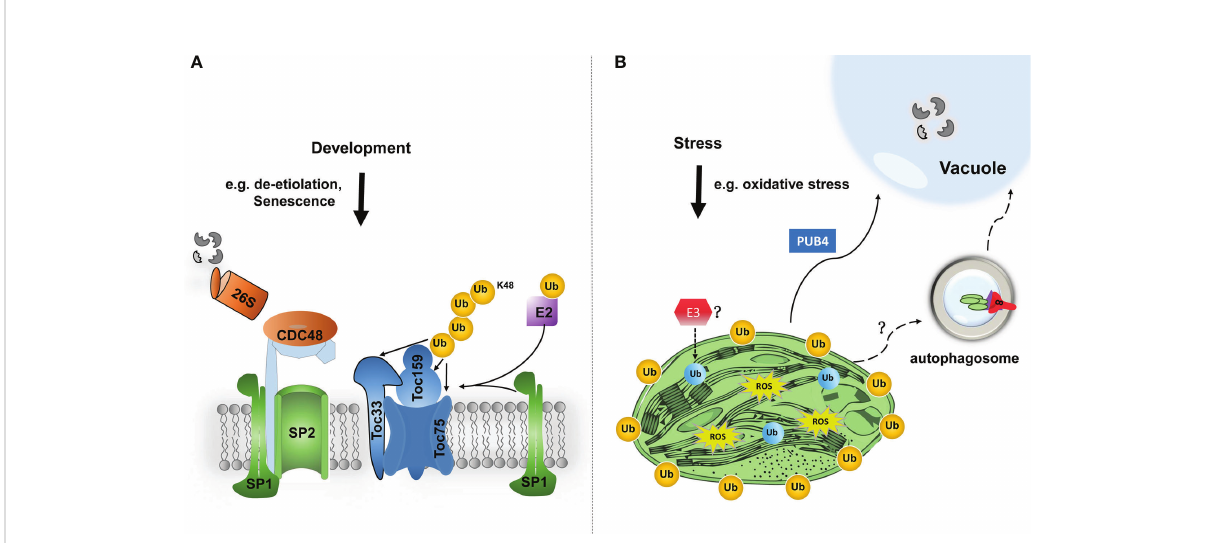
FIGURE 2 Modes of the functions of chloroplast protein ubiquitination in chloroplast proteostasis and functions. (A) In response to developmental signals, such as de-etiolation or fruit ripening, TOC components are ubiquitinated (Ub, in orange colour) by chloroplast-resident E3 ligase SP1 and an unknown cytosolic E2. Ubiquitinated TOC proteins are then retrotranslocated to the cytosol by SP2 channel and CDC48 chaperone, and fi nally degraded by the 26S proteasome. Such TOC turnover facilitates the reorganization of import machinery, and thereby changes the plastid proteome to cope with different developmental stages. (B) Under certain stress conditions, such as oxidative stress, photosynthesis tends to produce excessive reactive oxygen species (ROS), which will cause severe chloroplast damage. In that scenario, bulk chloroplast outer membrane proteins may be poly-ubiquitinated, by a cytosolic E3 ligase PUB4, which consequently promote the degradation of the entire damaged chloroplast through the interaction with the globular vacuole. How chloroplasts are delivered to the vacuole is still unclear. In addition, even internal chloroplast proteins are shown to be ubiquitinated (in blue colour) by an unknown mechanism, such as an E3 ligase. Based on the advanced understanding of mitophagy, such protein modi fi cation can potentially trigger selective autophagic degradation of the entire or partial